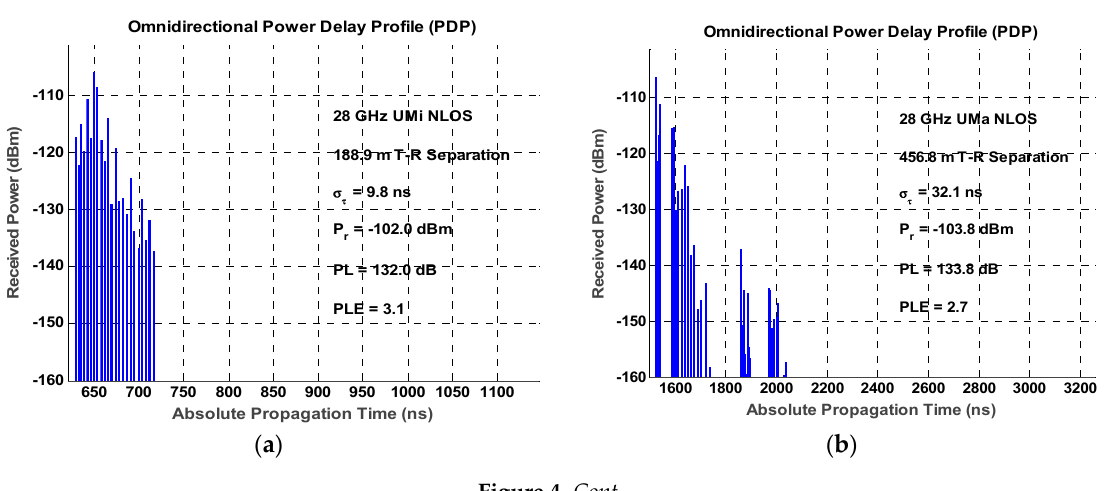
Omnidirectional Power Delay Profile (PDP) Figure 4. Cont